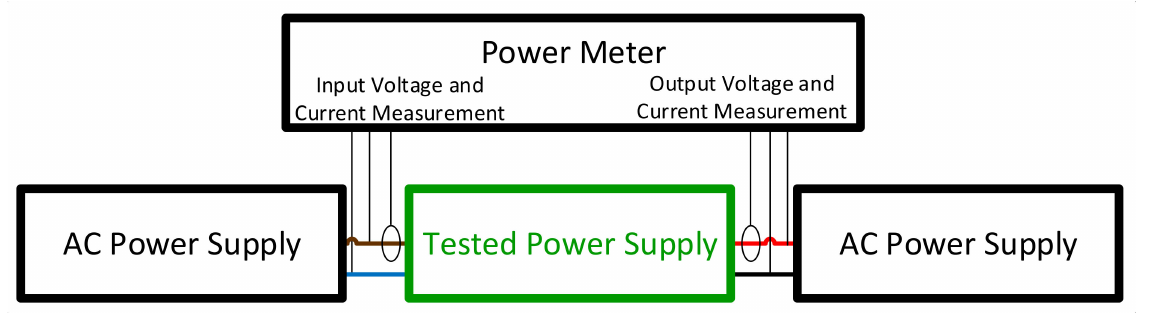
Figure 9. The efficiency measurement